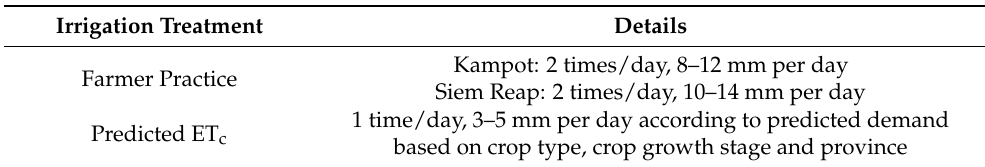
Table 3. Irrigation scheduling methods used at on-farm demonstration sites in Kampot and Siem Reap Provinces, Cambodia, in the 2019 growing